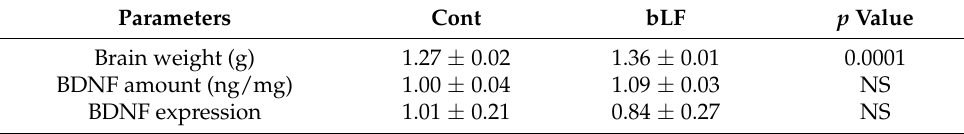
Table 3. Effect of bLF ingestion by the mothers on pup brain